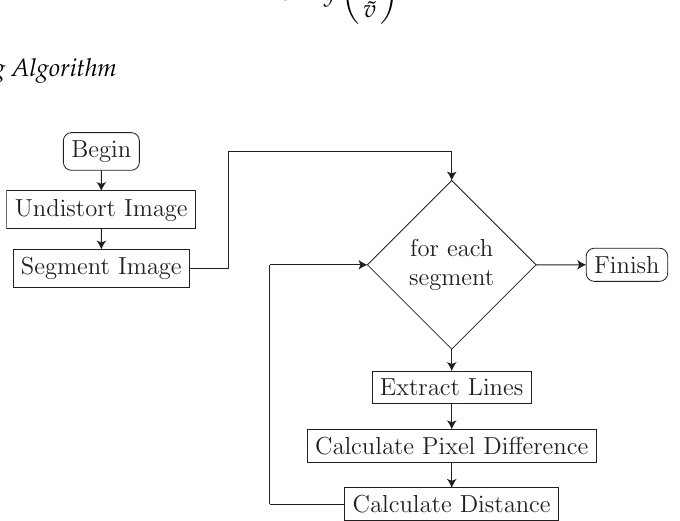
Figure 7. Overview of the distance calculation